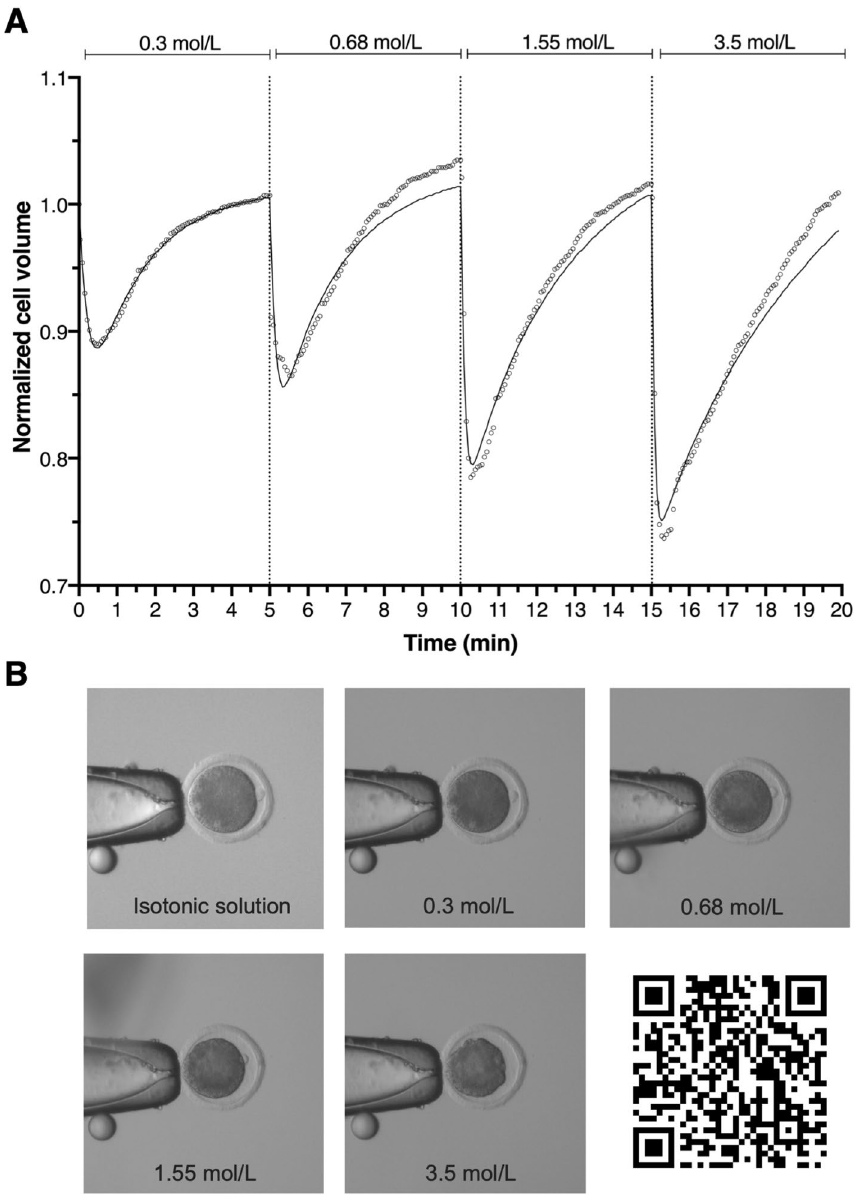
Figure 1. A representative sequence of the osmotic responses of MII bovine oocytes after exposure to increasing EG concentrations (0.3, 0.68, 1.55 and 3.5 mol/L). ( A ) The normalized cell volume data (open circle) and their corresponding theoretical fitting curves (solid line) obtained with the 2P model. Exposure to 0.3 mol/L EG starts at t = 0, and the change every 5 min to subsequent increasing EG concentrations is demarcated in the X-axis with a vertical dotted line. ( B ) An example of the oocyte’s morphology at relevant timeframes (at the minimal volume) is shown below each graphic (magnification 20x). Note shrinkage in response to increasing EG concentration. QR code links to a representative video time-lapse for an MII oocyte exposed to increasing EG